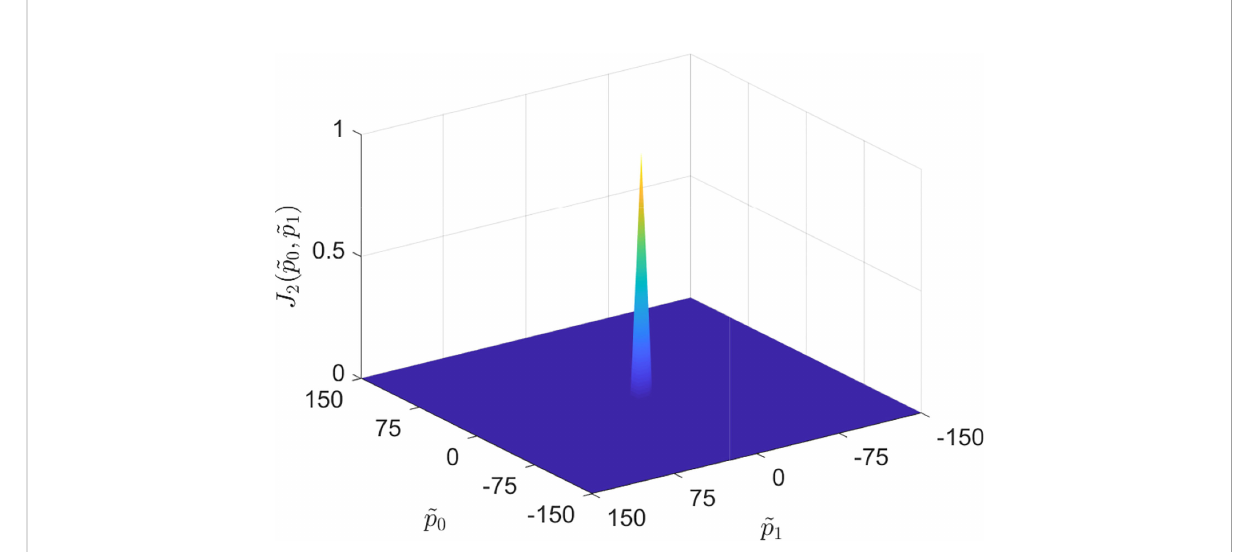
FIGURE 7 Normalized surface of J 2 [ n ( ˜ pu)] with U = 1 versus coef fi cients p ˜ u ∈ [ − 150,